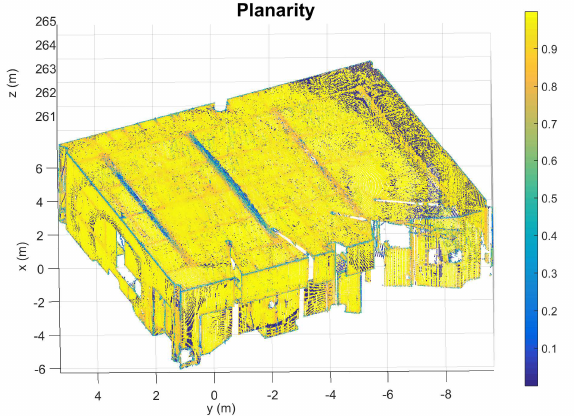
Figure 2. Classroom point cloud coloured with the planarity val-